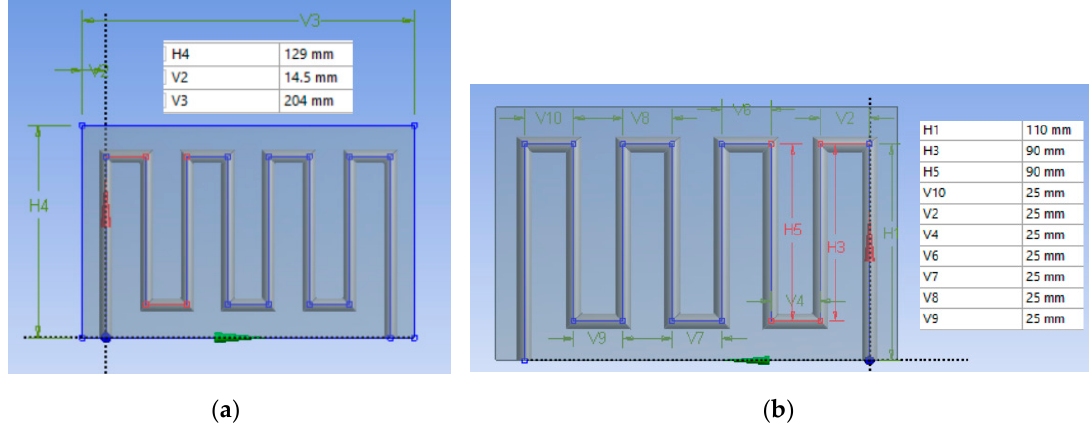
Figure 1. The dimensions of the cold plate. ( a ) External dimensions, ( b ) Internal dimensions.